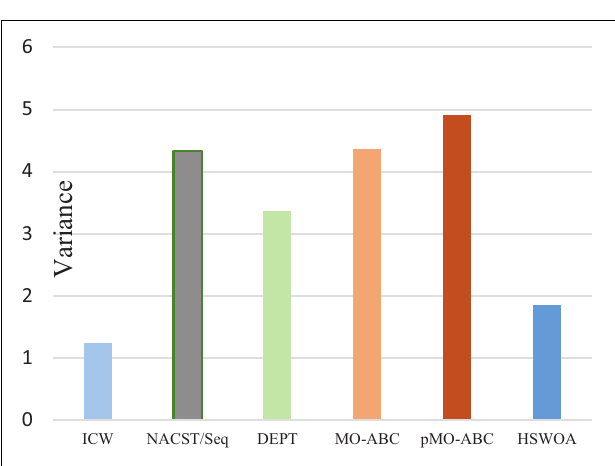
FIGURE 9 | Variance of different